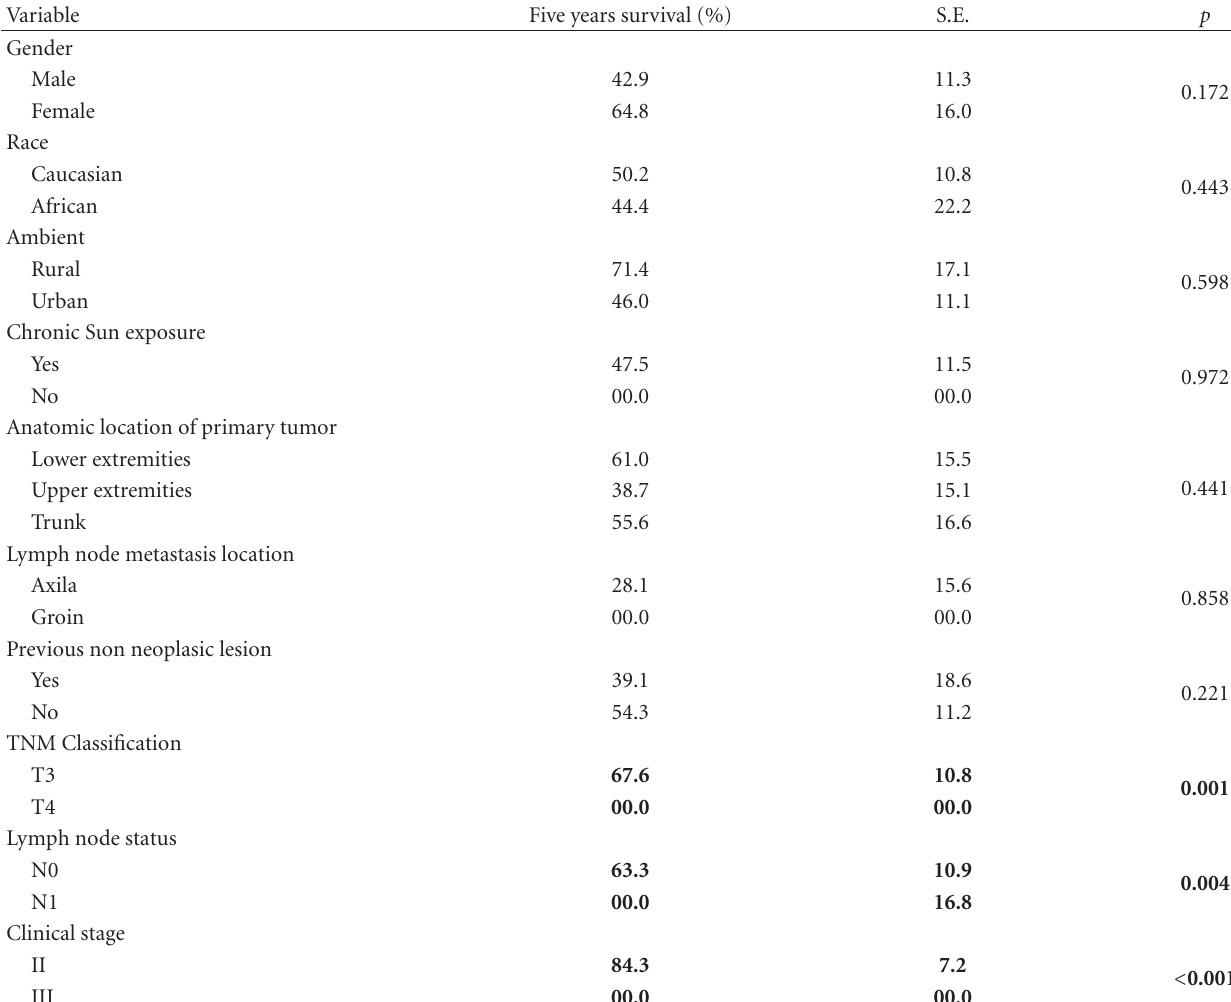
Table 3: Comparative specific cancer survival rates according to clinical variables in patients with locally advanced cutaneous squamous cell carcinoma of trunk and